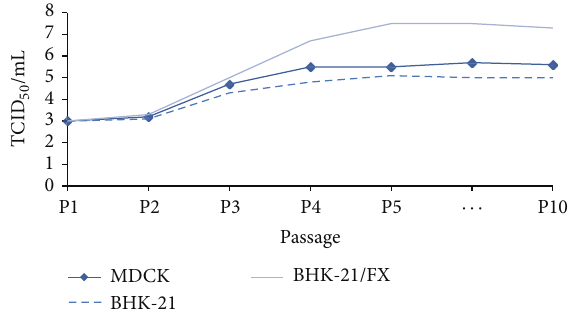
Figure 2: Replication of influenza virus in BHK-21/FX cells. The titer of virus in BHK-21/FX cell supernatants was assayed by TCID 50 in ten subsequent passages compared to the virus infected MDCK and BHK-21 cells supplemented with